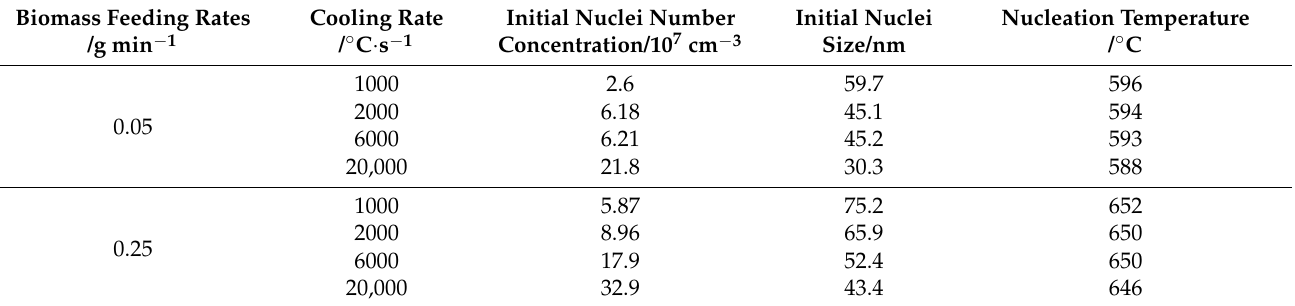
Table 1. The model calculated the initial nucleation number concentration, initial nucleation particle size, nucleation temperature, and initial nucleation rate of alkali chlorine gas, varying with cooling rates at two different cooling